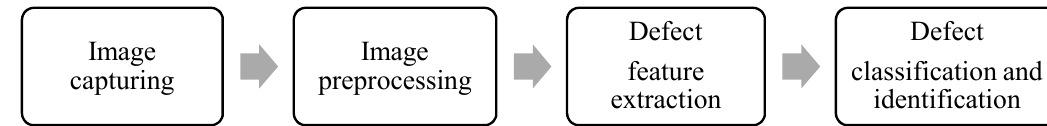
Figure 9. The flow chart of the surface defect detection system for steel plates.